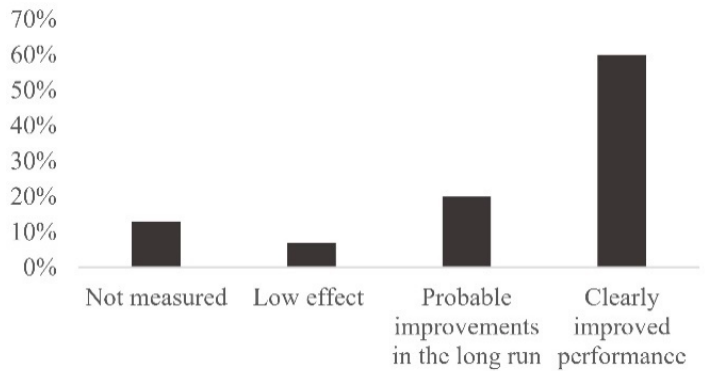
Figure 7. The impact of Industry 4.0 on companies in Kazakhstan.